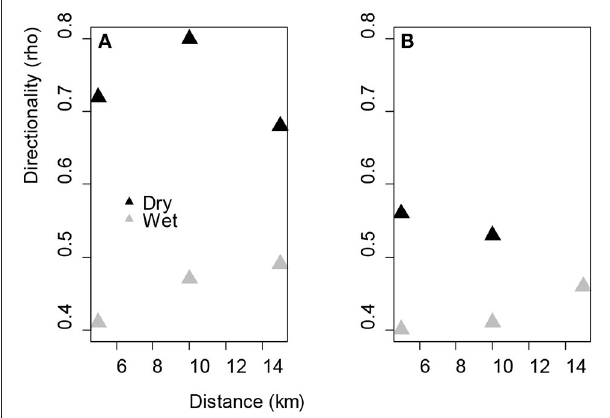
FIGURE 3 | Directionality of the movement patterns at different distances to water sources for (A) male elephants in the wet ( Rho at 5km = 0.41, 10km = 0.47, 15km = 0.49) and dry season ( Rho at 5km = 0.72, 10km = 0.8, 15km = 0.68) and (B) females in the wet ( Rho at 5km = 0.40, 10km = 0.41, 15km = 0.46) and dry season ( Rho at 5km = 0.56, 10km = 0.53). Rho = 0 represents a dispersed turn angles distribution, hence indicates weak directionality, and R = 1 shows that all angles are equal to the mean direction vector, hence indicates strong directionality. Females were not recorded to be at 15km from the nearest water point in the dry